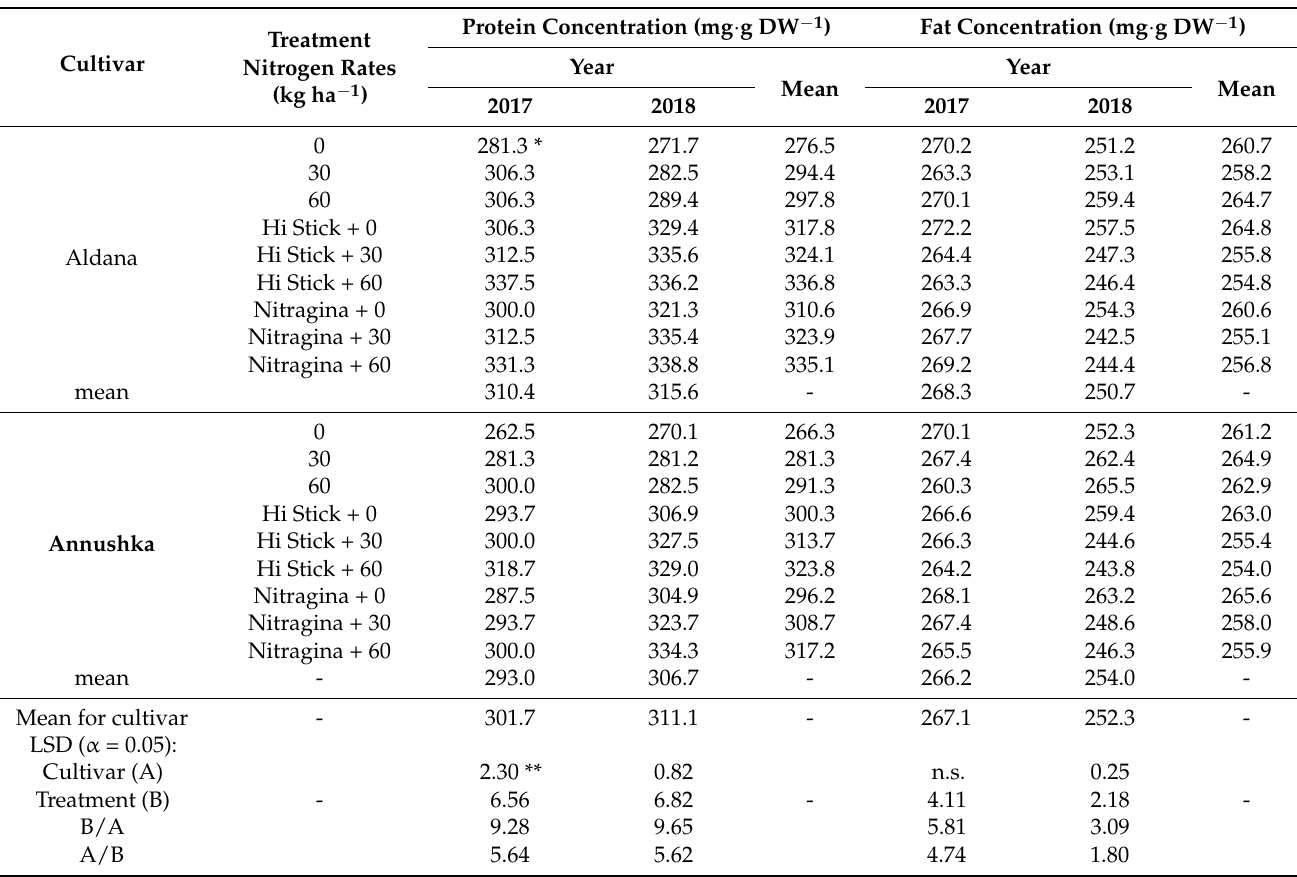
Table 7. Total protein and fat content in dry matter of the soybean seeds depending on the mineral N fertilization applied and the inoculation.